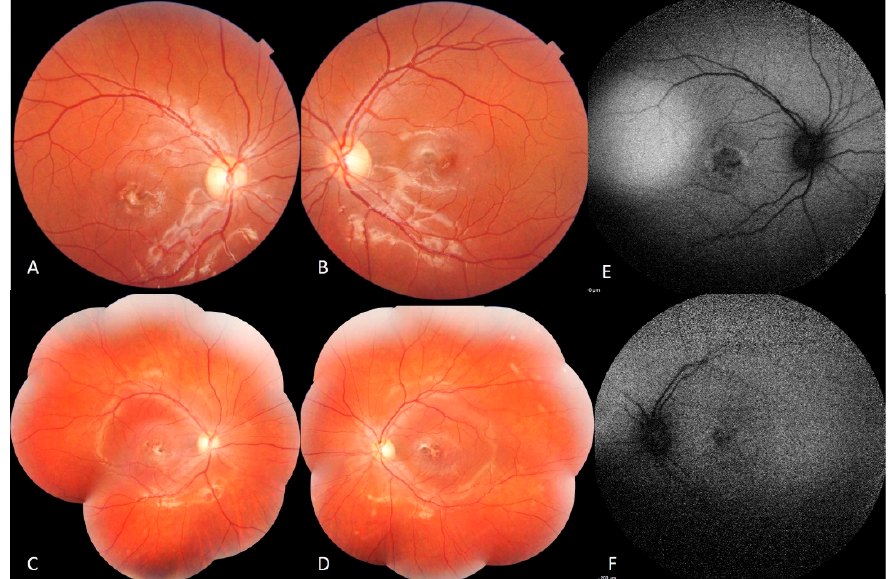
Figure 1. Color fundus photography (CFP) and blue-light FAF of macular dystrophy in the RE. ( A , B ) CFP: Macular fibrotic-pigmented lesion associated with yellowish punctuate deposits. Normal appearance of optic disc. ( C , D ) normal peripheral retina. ( E , F ) Blue-light FAF: Heterogeneous patchy central autofluorescence with increased perifoveal autofluorescence.